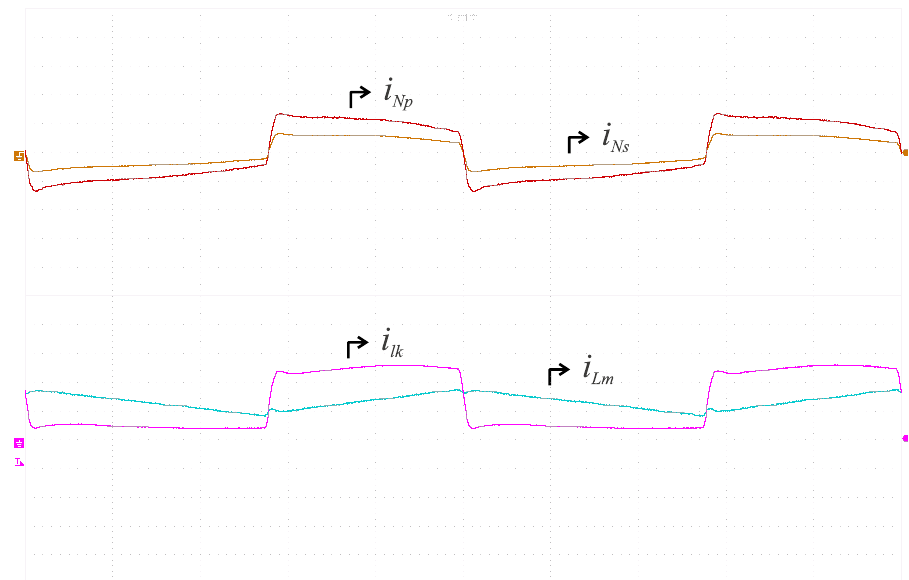
Figure 10. Top: primary winding N 1 p current (2 A/div) and secondary winding N 1 s (2 A/div); bottom: leakage inductance l k 1 current (2 A/div) and magnetizing inductance L m 1 current (2 A/div).